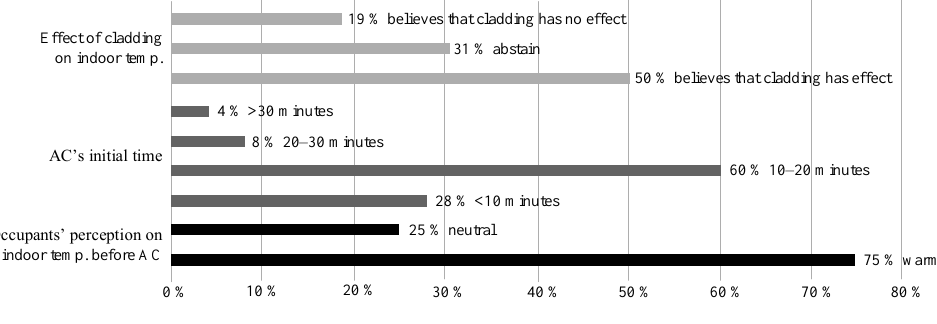
Fig. 17. Average temperature difference  of 3×24 hours measurement period.